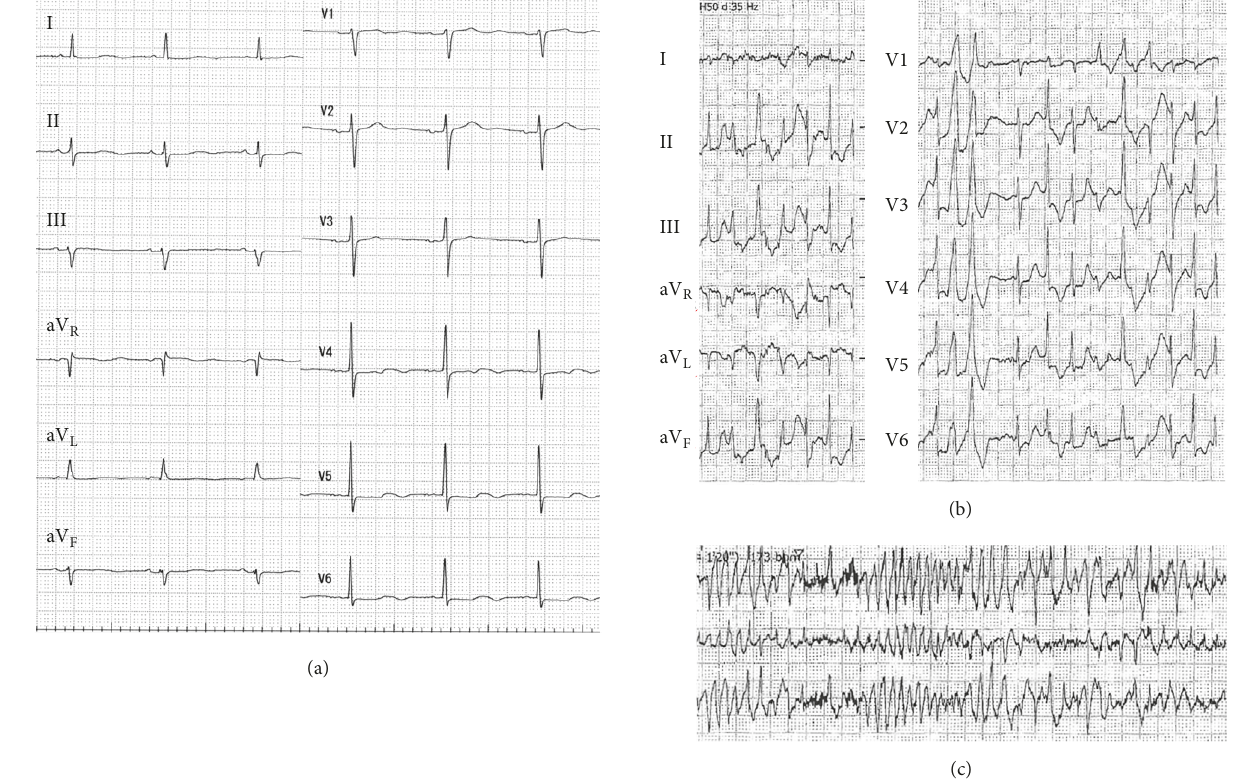
Figure 1: The 12 lead ECG in the patient. (a) The HR was 60bpm. Left axis deviation and enlarged U-waves were noted. An exercise test demonstrated polymorphic ventricular extrasystoles (b) which progressed to sustained polymorphic ventricular tachycardia